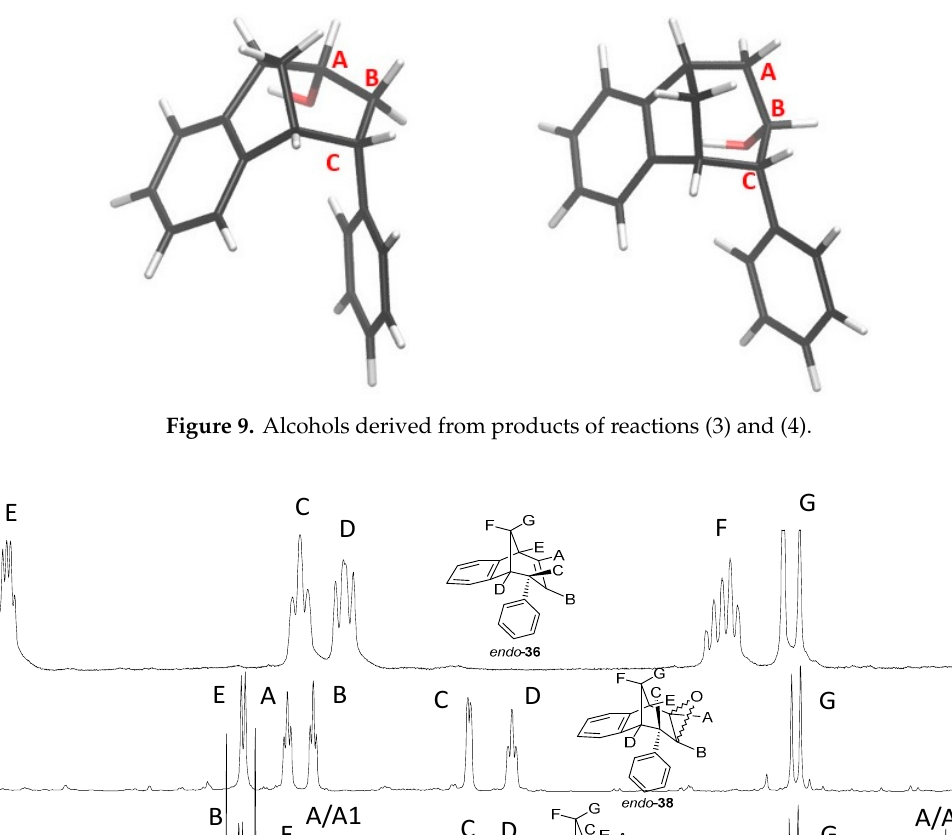
Figure 9. Alcohols derived from products of reactions (3) and (4).